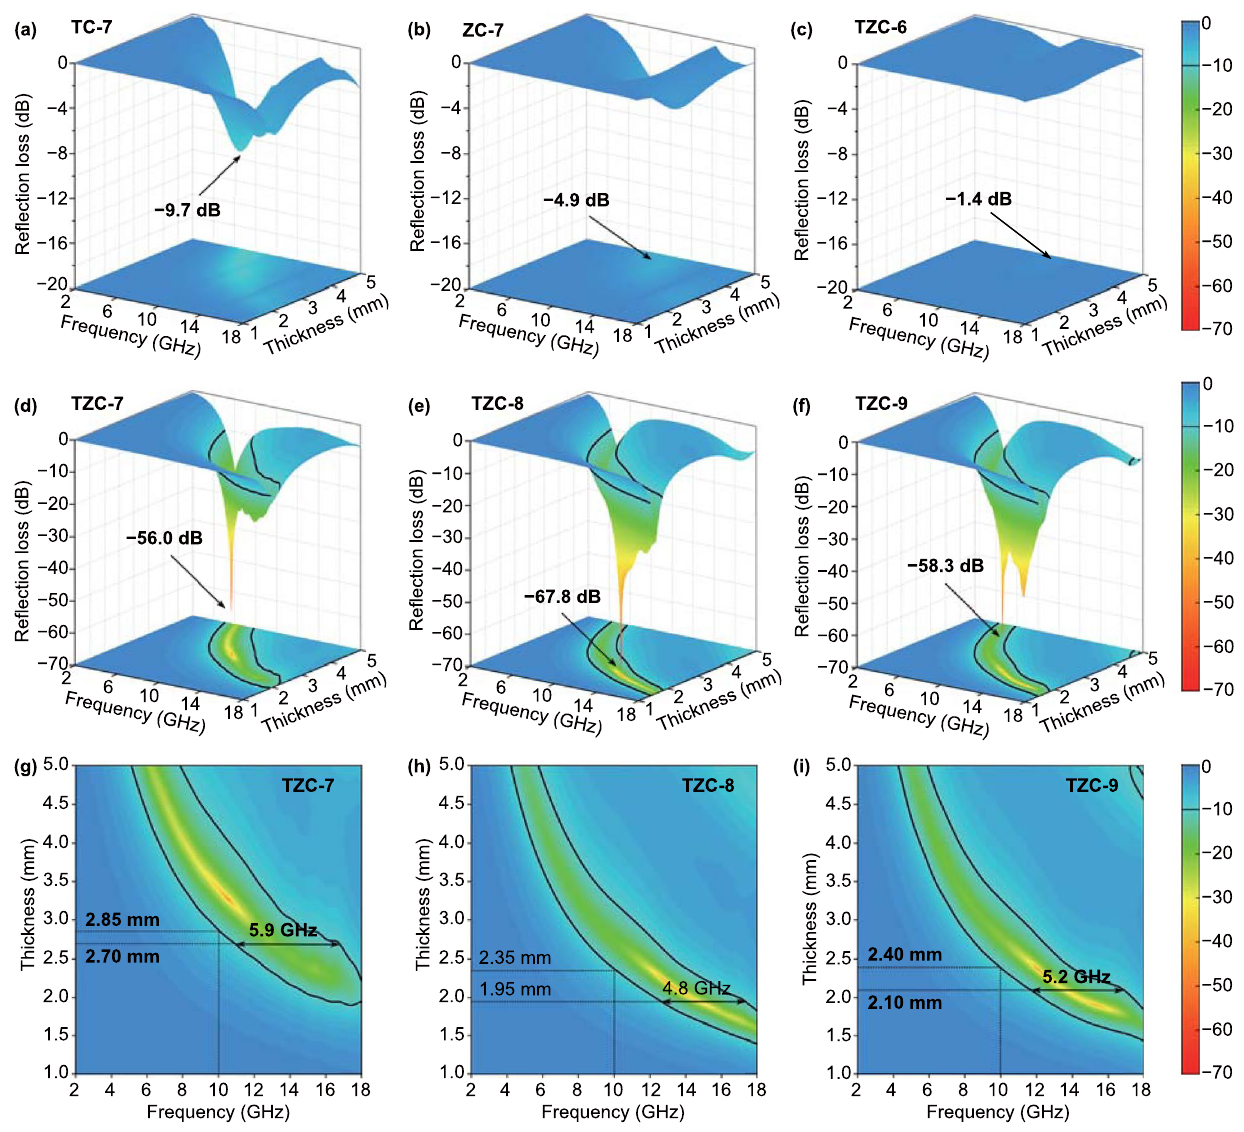
Fig. 5 Three-dimensional RL representations of a TC-7, b ZC-7, c TZC-6, d TZC-7, e TZC-8, and f TZC-9. Two-dimensional RL projection mappings of g TZC-7, h TZC-8, and i